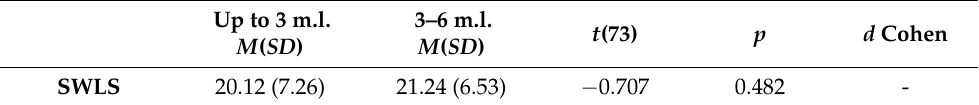
Table 4. The differences between women in terms of life satisfaction taking into consideration the age of a child. Up to 3 m.l.